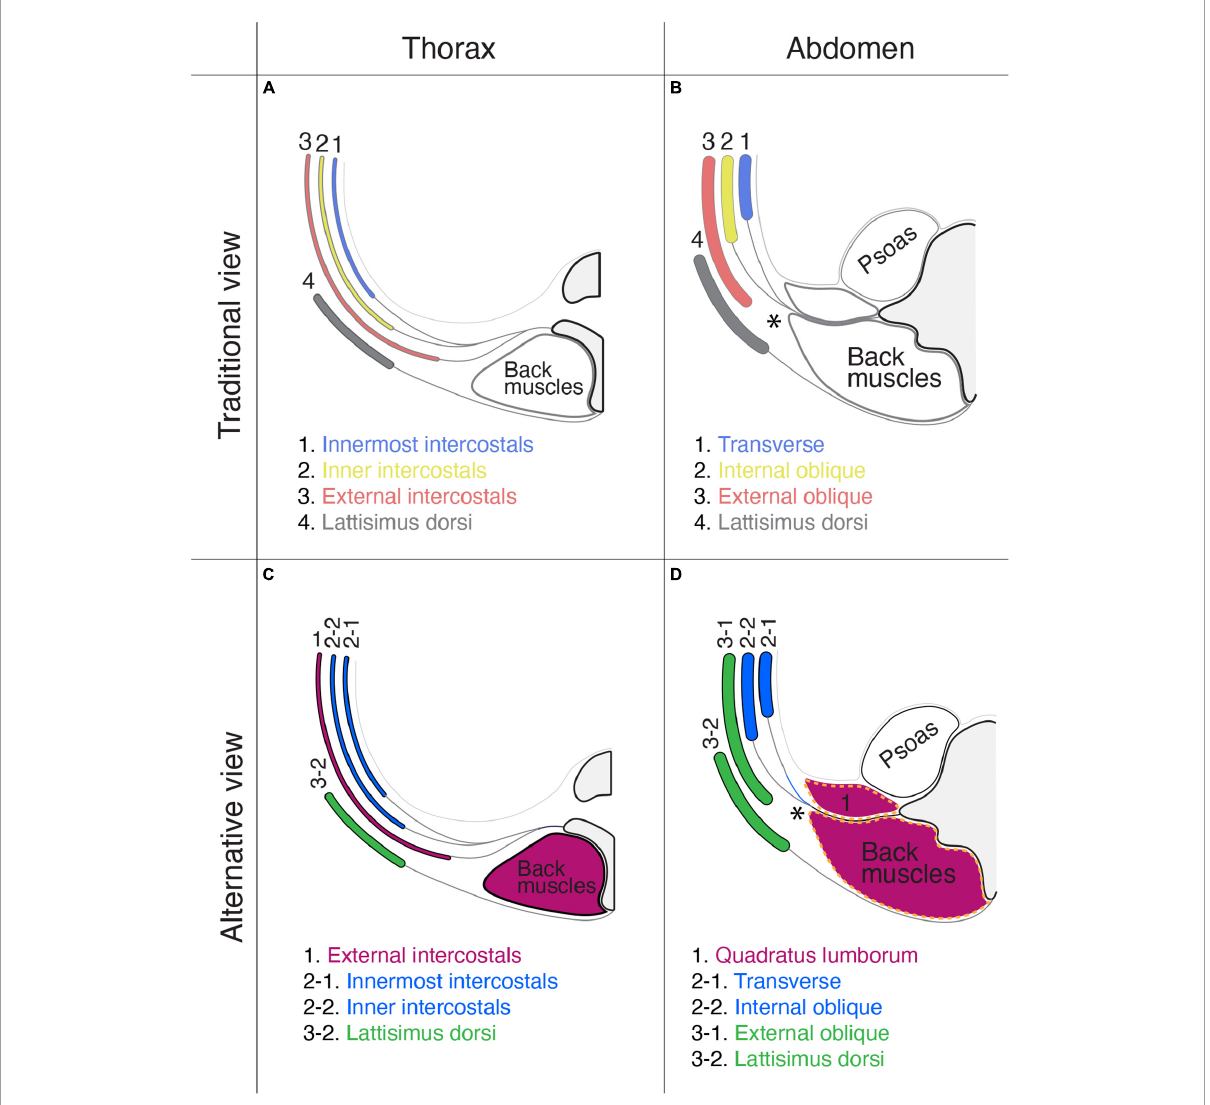
FIGURE14 Comparison of the layer organization of the body wall muscles between the traditional view and our view. The muscle homology between the thorax (A,C) and abdominal wall (B,D) . The homologous muscles are color-coded. In the traditional view (A,B) : (1) the innermost intercostal muscle corresponds to the transverse abdominis muscle; (2) the internal intercostal muscle corresponds to the internal oblique abdominis muscle; (3) the external intercostal muscle corresponds to the external oblique abdominis muscle; and (4) the latissimus dorsi is outside the body wall. In the proposed alternative view (C,D) : (1) the external intercostal muscles are equivalent to the quadratus lumborum; (2) the internal and innermost intercostal muscles correspond to the internal oblique and transverse abdominis; and (3) the external oblique abdominis is closely related to the latissimus dorsi. In panel (D) , the thoracolumbar fascia is indicated by broken orange lines. In panels (B,D) , asterisks indicate the lateral